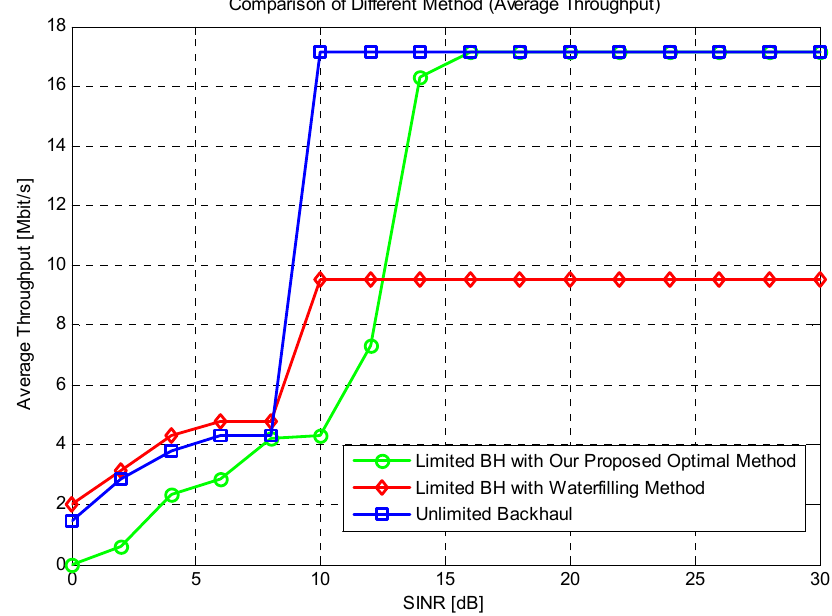
Figure 7. Throughput performance of different SINR.